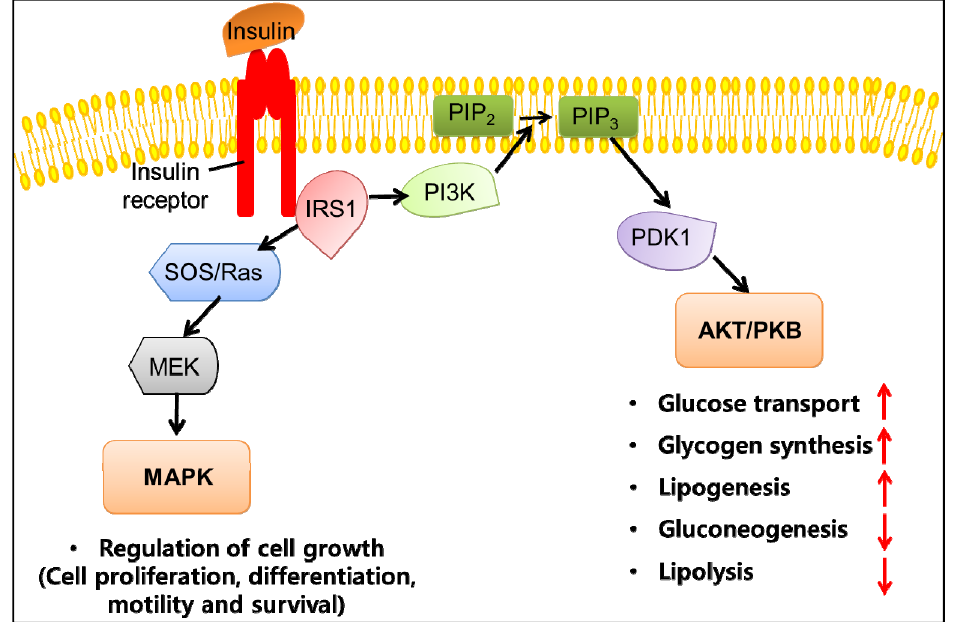
Figure 3. Schematic view of insulin signaling pathway in adipose tissue. Binding of insulin to its receptor on adipocytes triggers the phosphorylation and activation of insulin receptor substrate, which forms a docking site for phosphatidylinositol 3-kinase (PI3K) at the membrane. When docked, PI3K converts phosphatidylinositol 4,5-bisphosphate to phosphatidylinositol 3,4,5-trisphosphate, a second messenger that activates phosphoinositide-dependent protein kinase 1 and recruits Akt (also known as protein kinase B, PKB) to the cell membrane. Consequently, PI3K-AKT/PKB signaling pathway regulates metabolic processes. The red arrows indicate up-regulation (when pointing upward) or down-regulation (when pointing downward) in response to PI3K-AKT/PKB signaling pathway. The Ras-mitogen-activated protein kinase pathway leads to the activation of genes which are involved in cell growth, thereby promoting inflammation and atherogenesis. IRS-1, insulin receptor substrate; MAPK, mitogen-activated protein kinase;